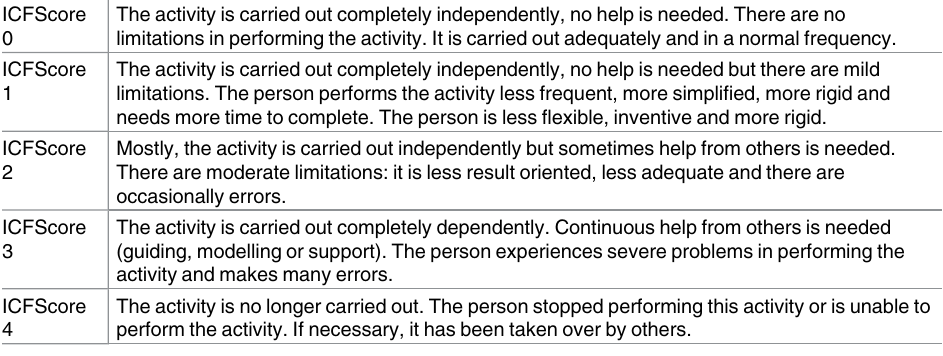
Table 3. Scoring systemadopted from the performance qualifiers of the